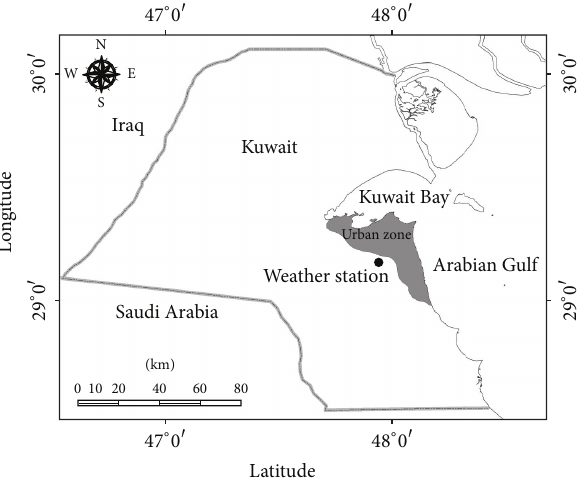
Figure 1: Location of the weather